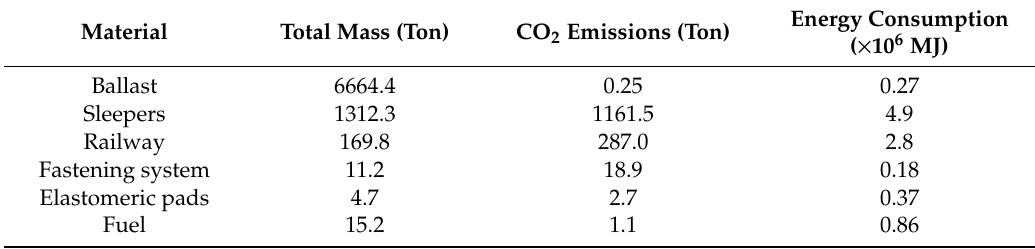
Table 9. CO 2 emissions and energy consumption of material production for rail construction.